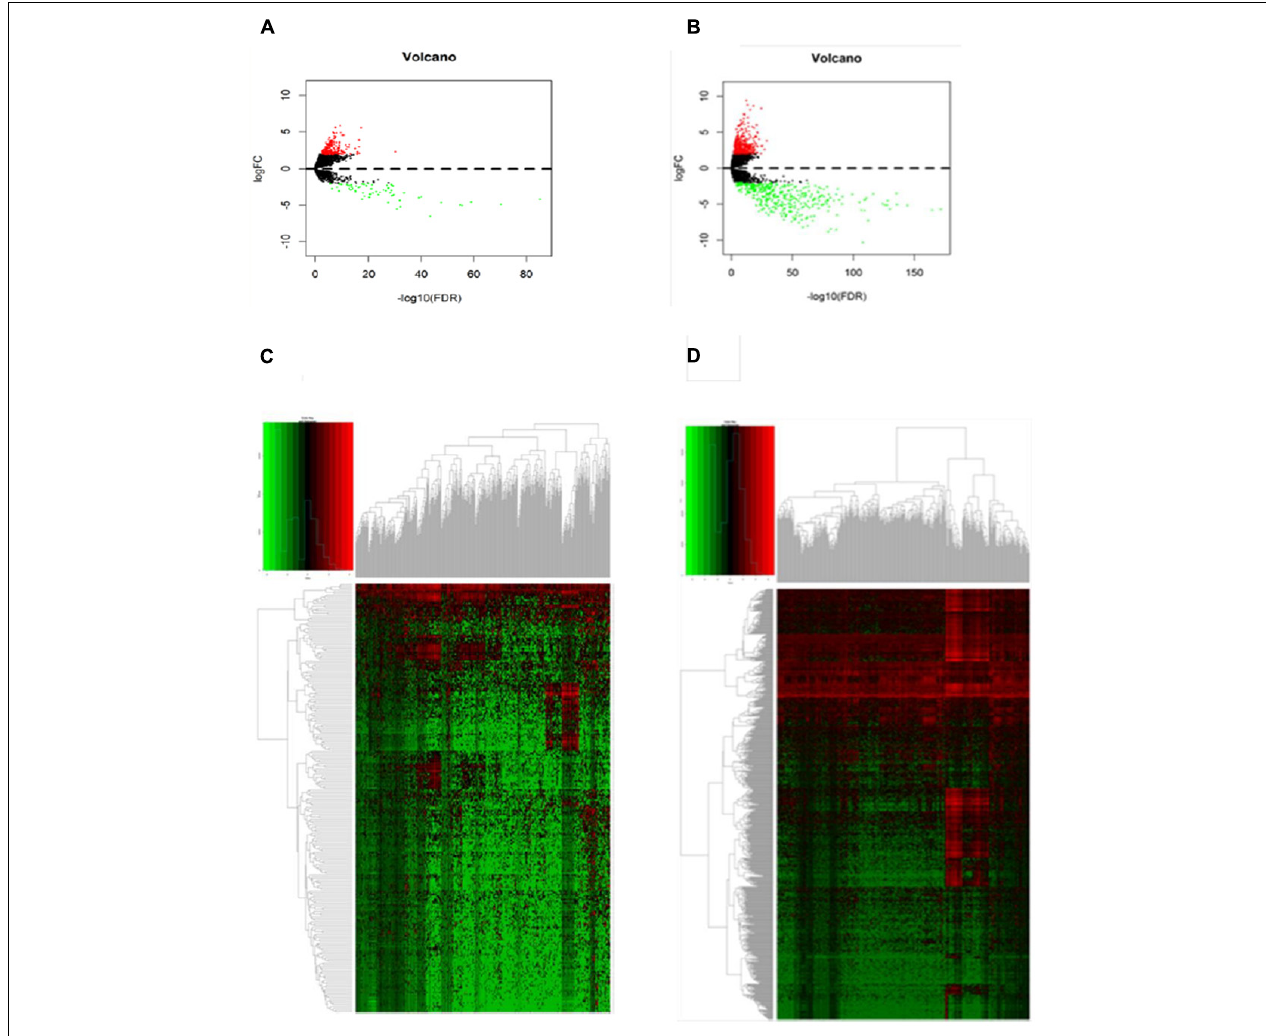
FIGURE 1 | Differentially expressed genes between primary and metastatic melanoma (fold change > 2, FDR < 0.01). (A) Volcano plot of the FDR as a function of weighted fold change for DElncRNAs and (B) DEmRNAs, red dots represent significantly upregulated expressed genes and green dots represent significantly downregulated expressed genes (fold change > 2, FDR < 0.01). (C) Heat map for potential lncRNAs ( n = 246) showed significant expression changes, in which 62 were downregulated and 184 were upregulated. Red through green color indicates high to low expression level. (D) Heat map for potential mRNAs showed significant expression changes ( n = 856), in which 428 were downregulated and 428 were